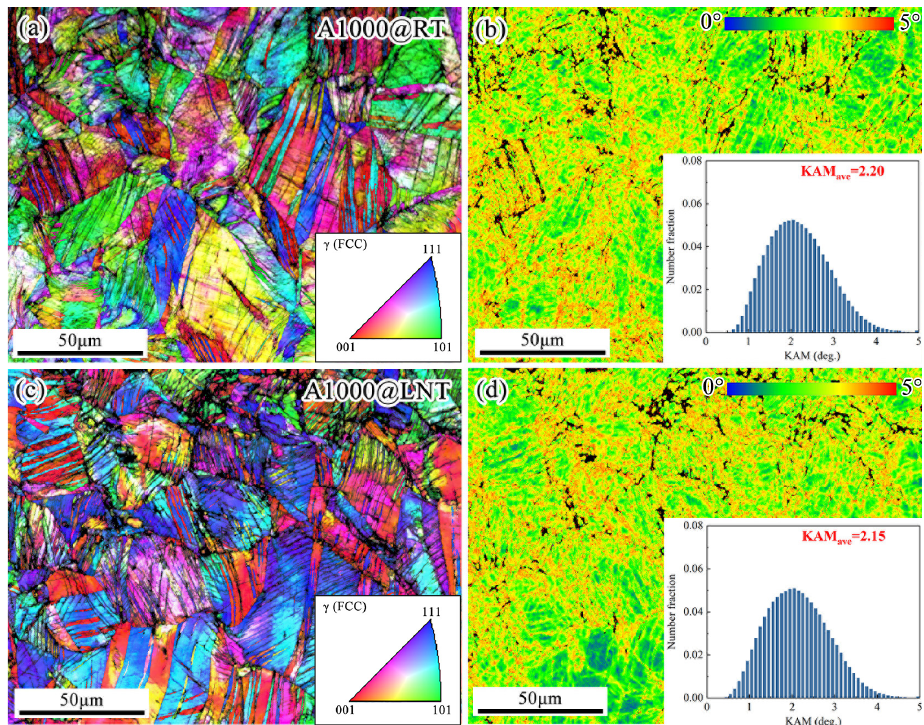
Figure 9. EBSD characterization of deformed microstructures underneath fracture surface of A1000 Charpy V-notch impact specimen at ( a , b ) RT and ( c , d ) LNT. ( a , c ) IPF + IQ maps. ( b , d ) Corresponding KAM maps and statistical KAM data (see insets).